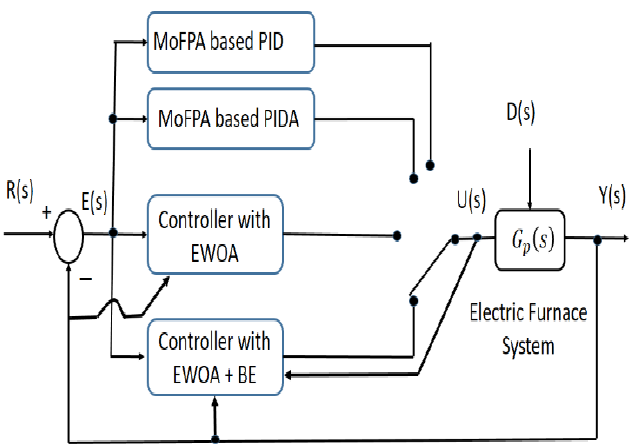
Figure 5. Temperature control system using three control techniques.